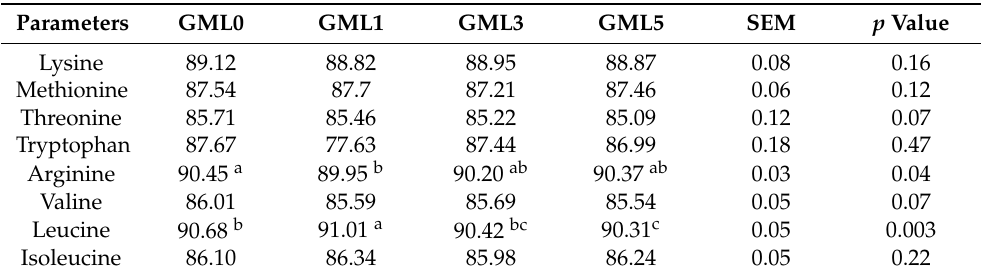
Table 3. The effect of glycerol monolaurate supplementation on the apparent ileal digestibility coefficient (AID%) of amino